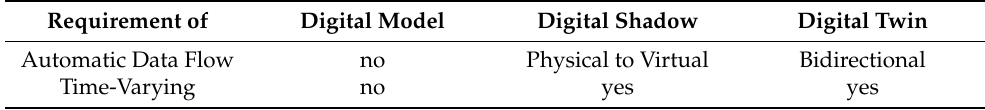
Table 4. Improved categorization of DTF by necessary